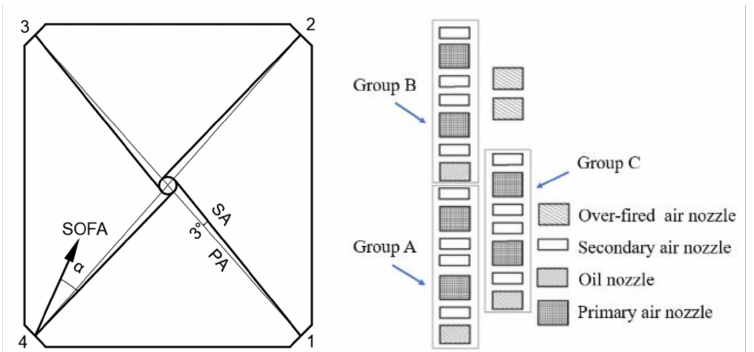
Figure 2. Burner section and vertical